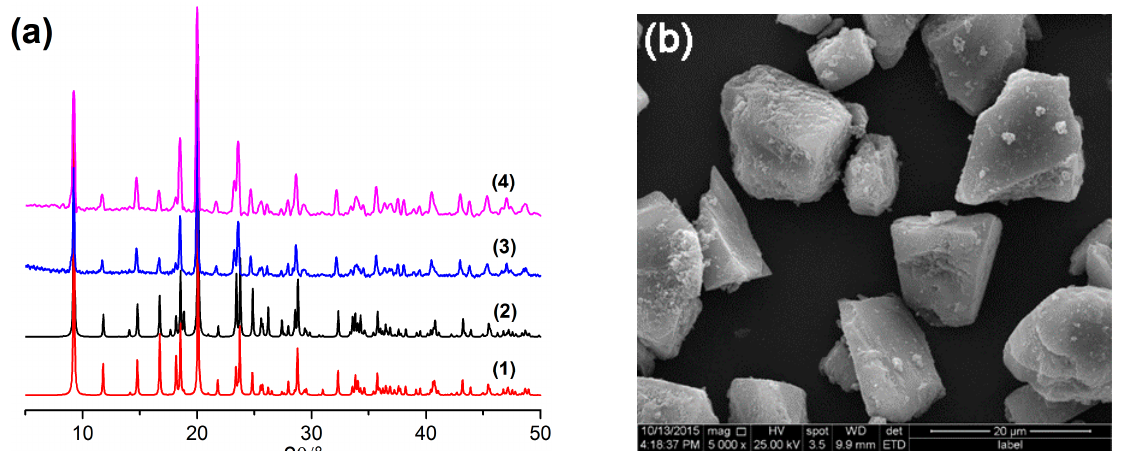
Figure 2. ( a ) Powder X-ray diffraction (PXRD) patterns of [Co( L -tyr)] n ( L -tyrCo): (1) simulated from single crystal X-ray diffraction data, (2) as-synthesized, (3) after the experiment, (4) after soaking in a large volume of methanol and n-hexane/isopropanol (70/30, v / v ) for 48 h; ( b ) SEM image of the selected [Co( L -tyr)] n ( L -tyrCo) particles.